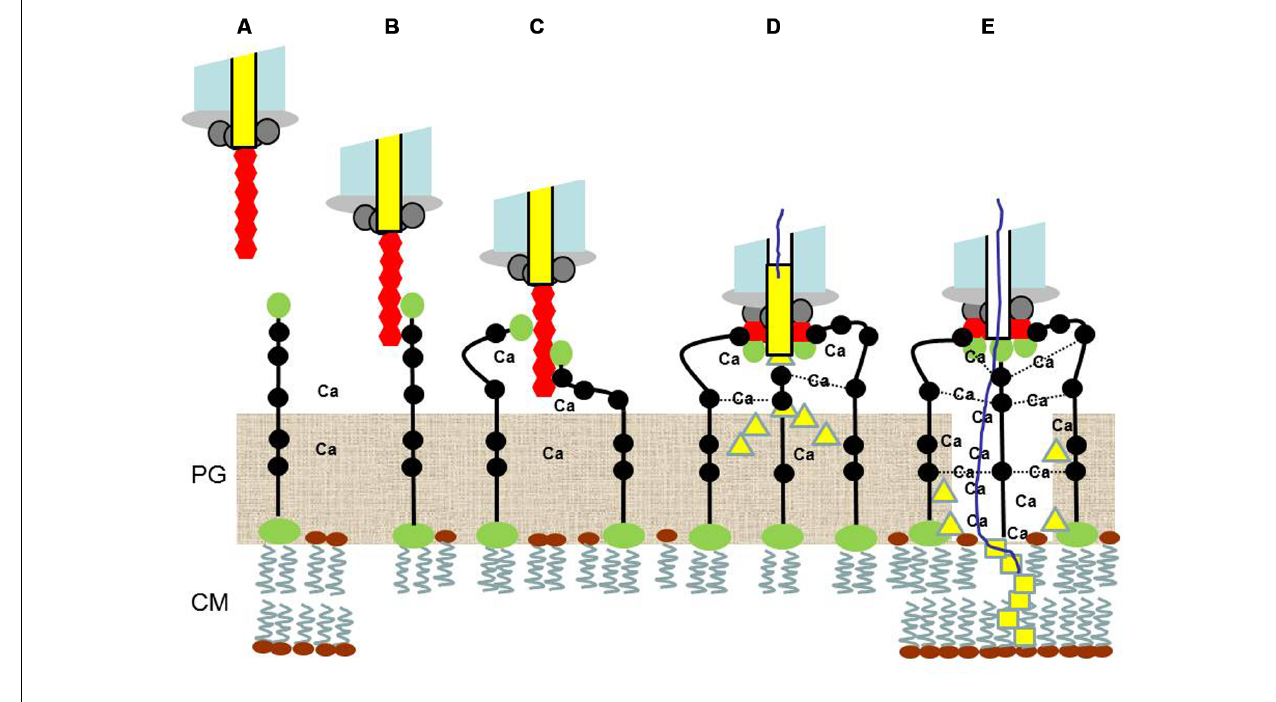
attached to the end of the tail base for the release of the TMP homologs ORF546 (SP54?) and ORF351 from the tail core into the space restricted by the SP58-bound LTA molecules and further stabilized with calcium (Ca) bridges. (E) The PG-degrading activity of ORF546 proteins (yellow triangle) produces additional space for the formation of the stable Ca-LTA channel between the end of the tail base and the cytoplasmic membrane (CM). The Ca-LTA channel provides a gateway for ORF351 proteins (yellow square) to interact with the CM, and to further guide the transfer of the linear phage LL-H DNA complexed with calcium, through the CM into the cytoplasm of the infected host bacterial